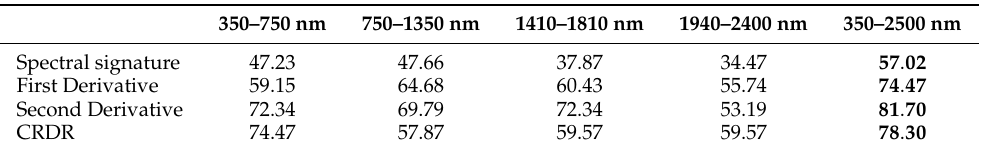
Table 9. Overall classification accuracy (%) for different spectral ranges considering Median reflectances as spectral reference database and Canberra distance.